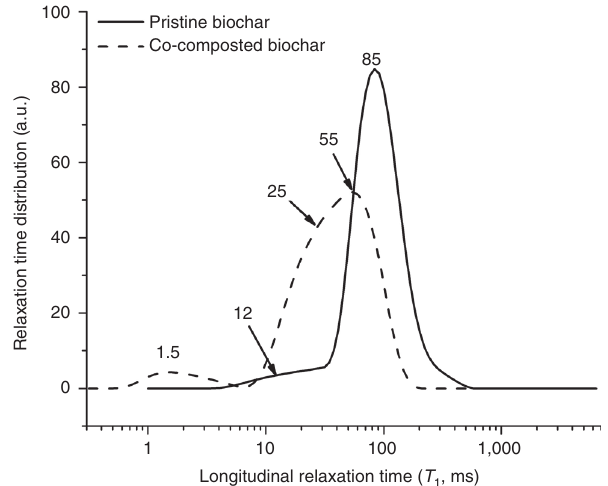
Fig. 7 Analysis of biochar surface hydrophilicity by fast fi eld cycling nuclear magnetic resonance relaxometry: Relaxograms, i.e., distribution of relaxation times, of pristine and co-composted biochar. The shorter the T 1 value, the better water molecules are anchored to the biochar surface. Conversely, the longer the longitudinal relaxation time, the weaker are the